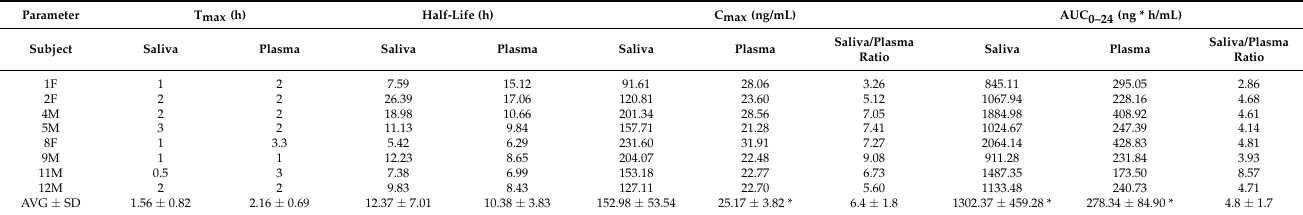
AUC: area under the plasma/saliva concentration-time curve; C max: maximum concentration of matrine in plasma/saliva; T max : time to achieve maximum concentration of matrine in plasma/saliva. (*) indicates the significant difference between plasma and saliva ( p <